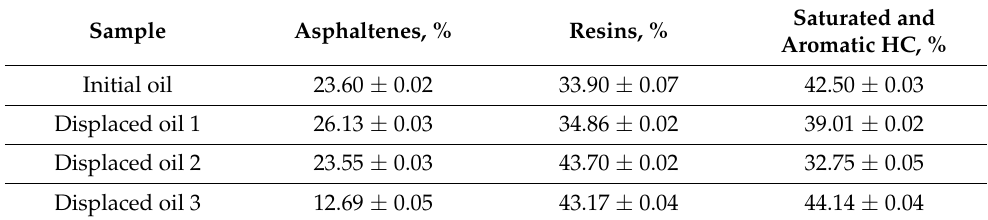
Table 1. Changes in the group composition of oil.